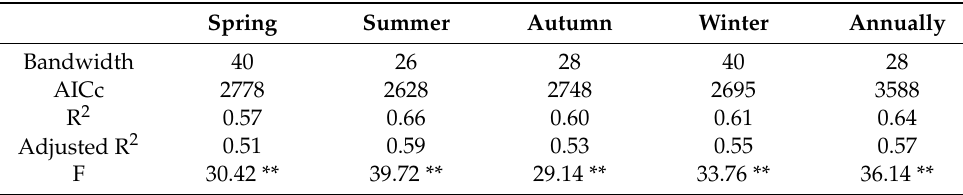
Table 2. The fitting tests and the performance of the GWR